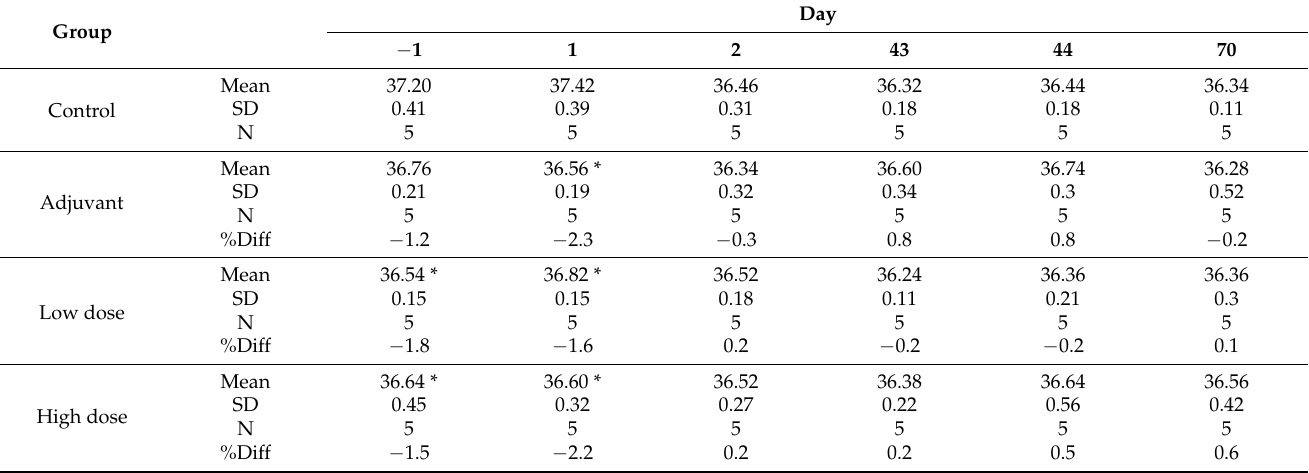
Table 1. Time course of body temperature.